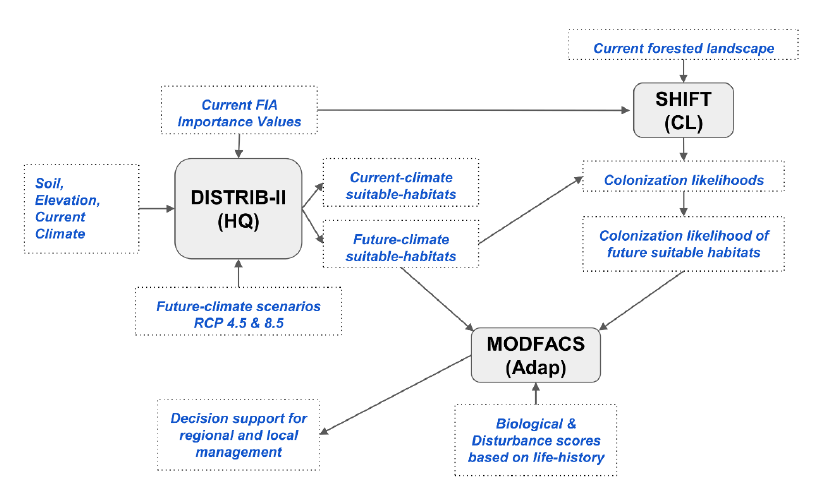
Figure 2. Flowchart depicting workflow to produce the DISTRIB-II and SHIFT outputs. DISTRIB-II predicts current and future habitat suitability/quality (HQ) and SHIFT calculates colonization likelihoods (CL) and ModFacs estimates adaptability (Adap).